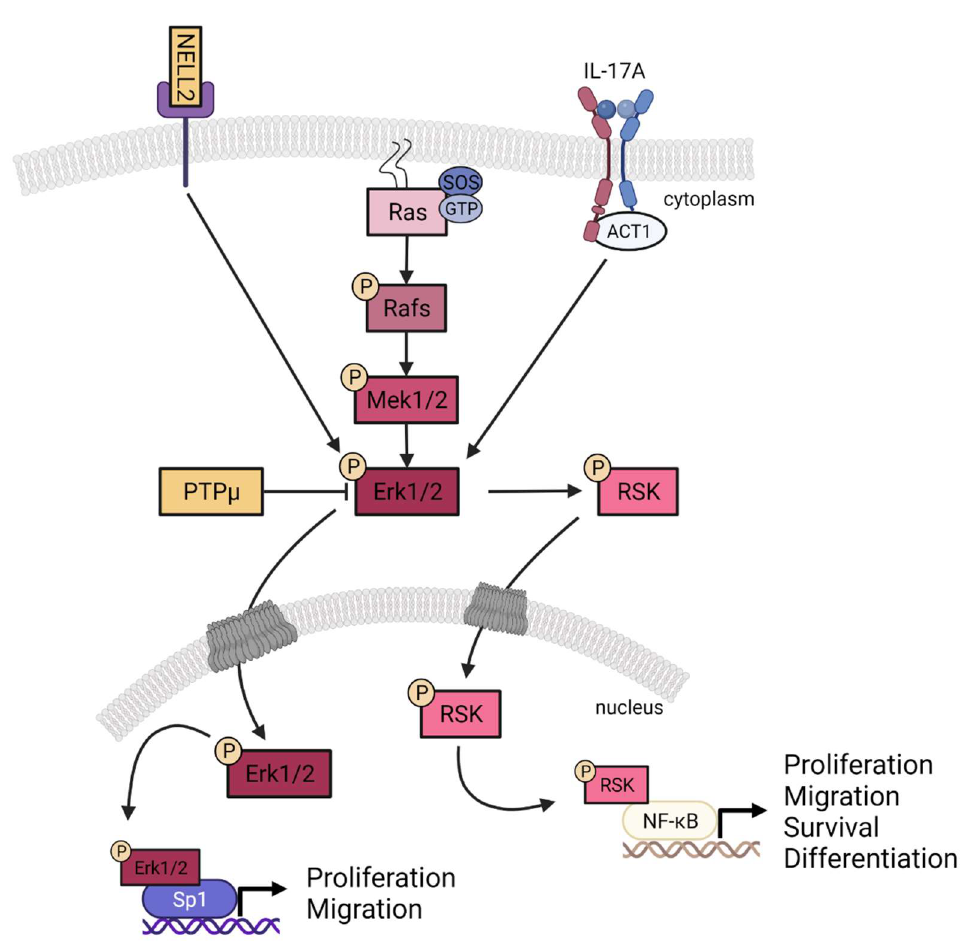
Figure 6. Contribution of PTP µ and NELL2 to the ERK1/2 signaling pathway. NELL2 contributes to the activation of ERK1/2 while PTP µ inhibits its activation through dephosphorylation. In our T cell- enriched psoriatic skin substitutes, NELL2 expression was upregulated, whereas that of PTPµ was decreased, both resulting in an overactivation of the ERK1/2 signaling pathway.